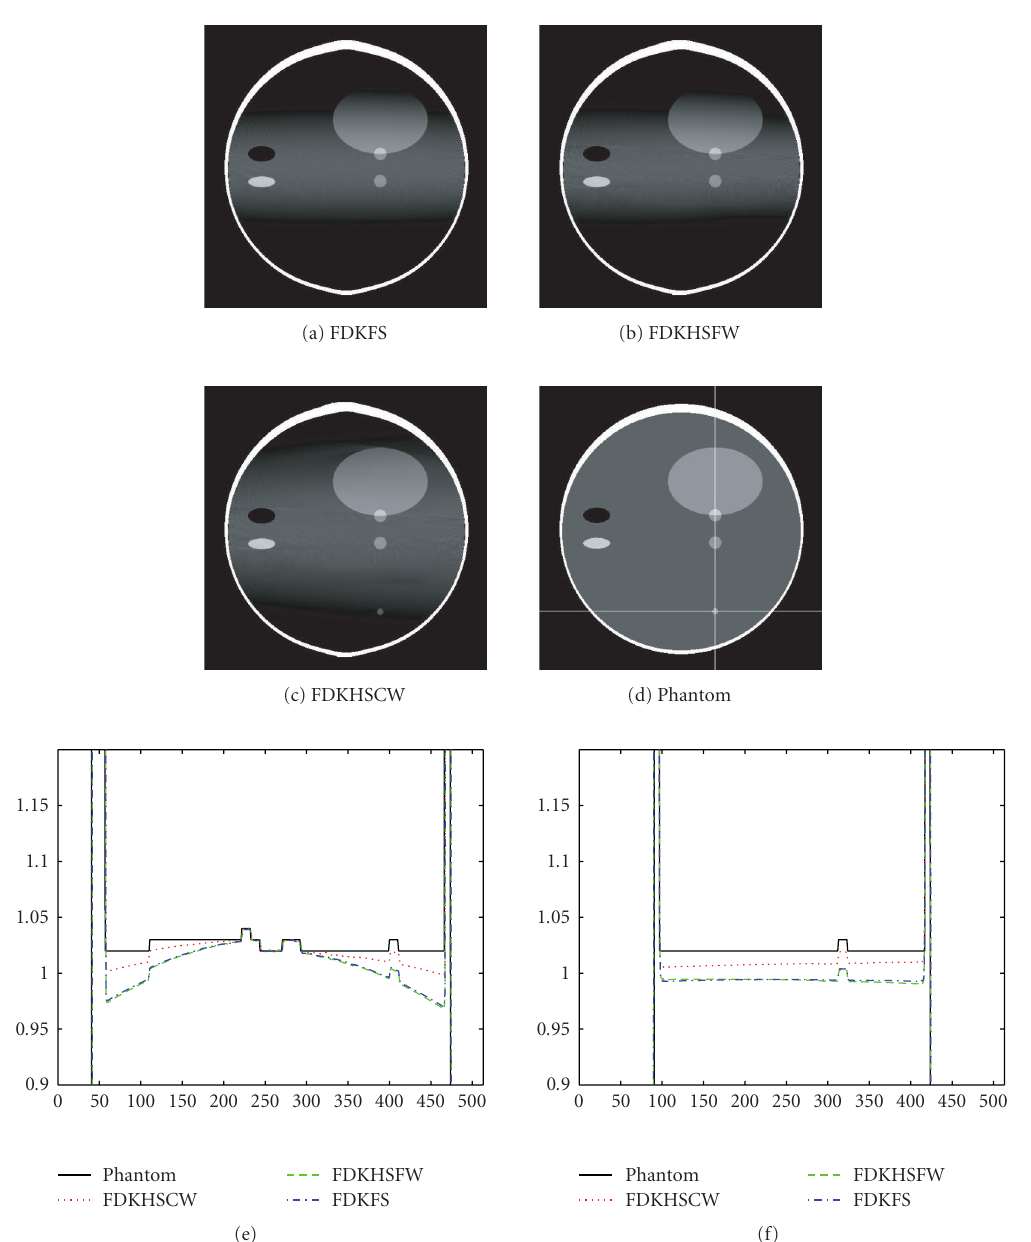
Figure 4: Reconstructed sagittal image from di ff erent FDK schemes at X = 0mm and respective line profile comparison in (e) and (f) along the solid vertical and horizontal white line shown in